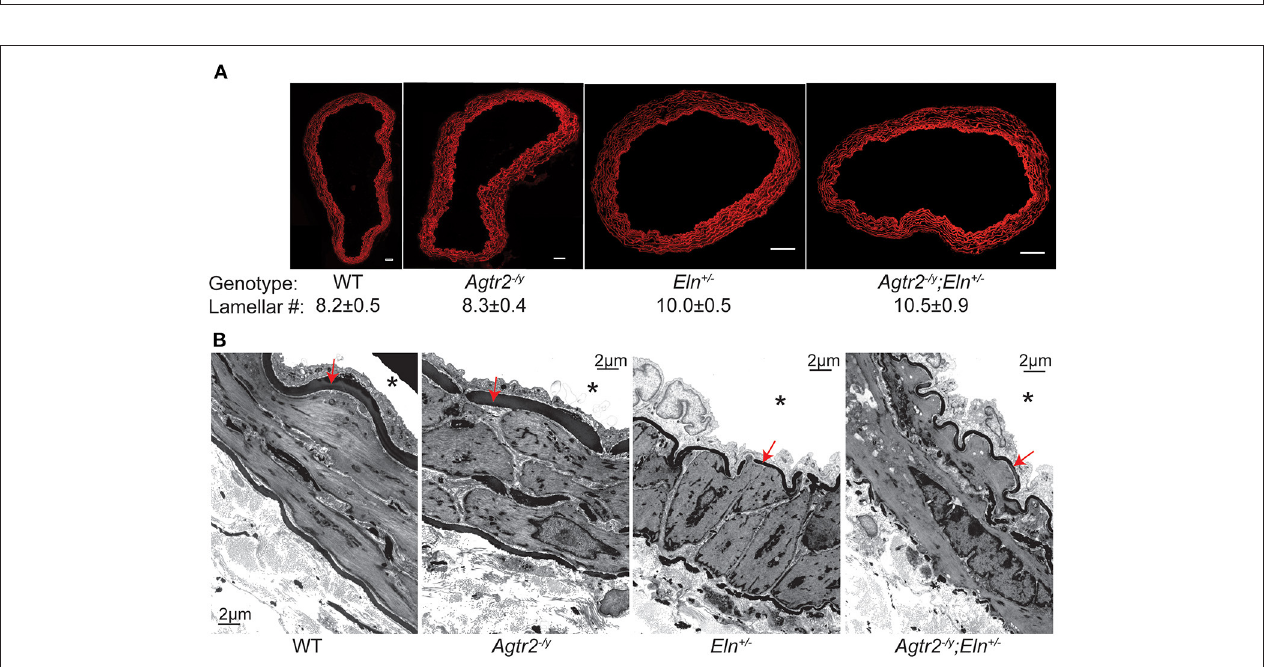
FIGURE 3 | Loss of AT2R does not affect arterial structure. Representative cross sections of Alexa-633 hydrazide-stained ascending aorta from WT, Agtr2 − / Y , Eln + / − , and Agtr2 − / Y ;Eln + / − mice along with the respective average lamellar number ± standard error of the mean, n = 3–4 per group, scale bar = 50 µ m (A) . Transmission electron micrographs of mesenteric arteries from all genotypes, *indicates vessel lumen and red arrow indicated internal elastic lamina (B)